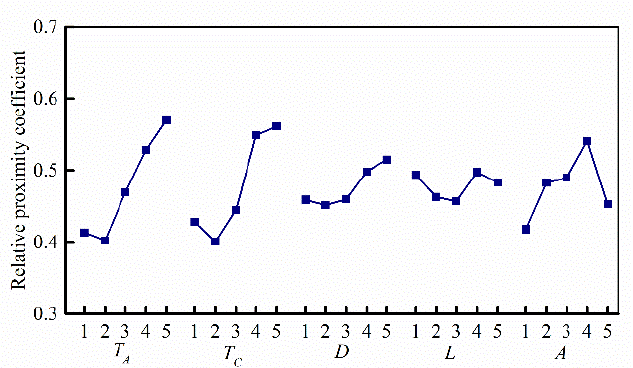
Figure 13. Main effect diagram of levels for each factor of the CFRP-Al hybrid tube.